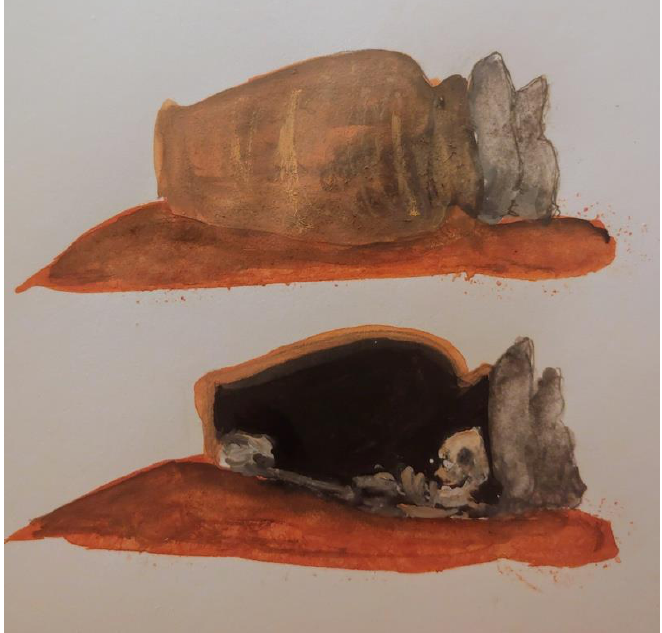
Figure 4. Idealized illustration of a pithos burial (drawing by Lilly Woodard). Notes: The author has obtained the copyright of this figure in this article.